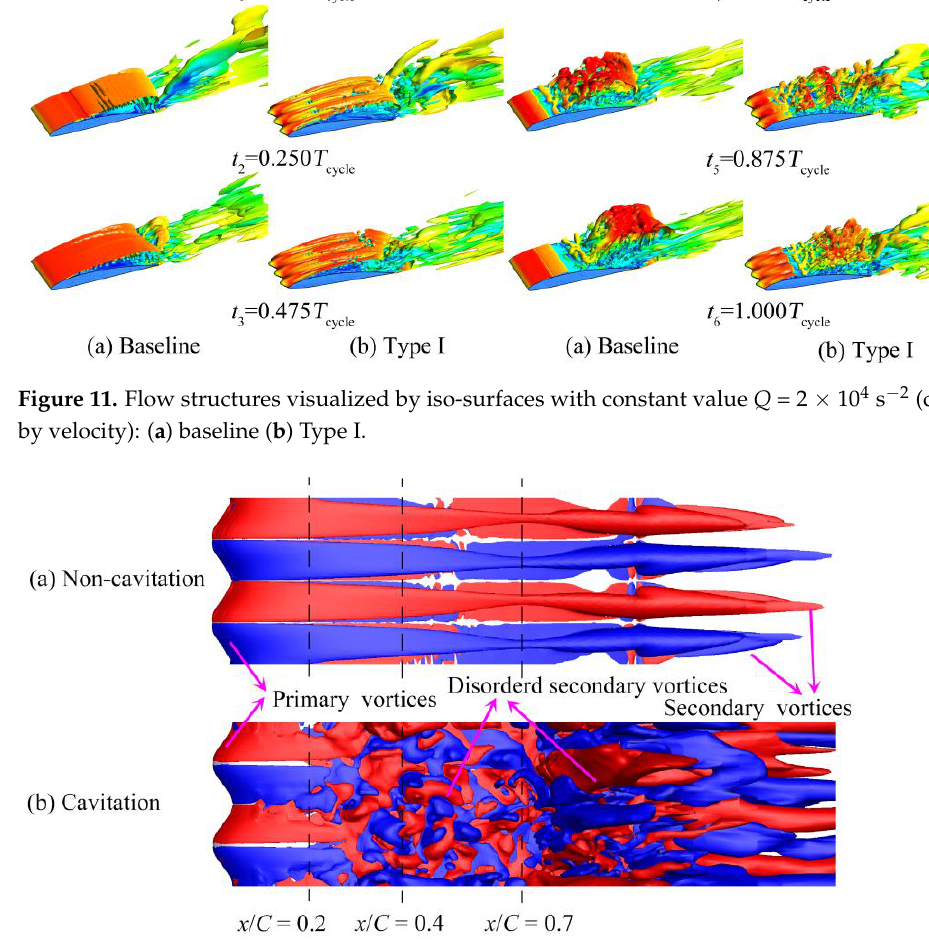
Figure 12. Iso-surface of ω x = 200 (red) and ω x = -200 (blue) under two